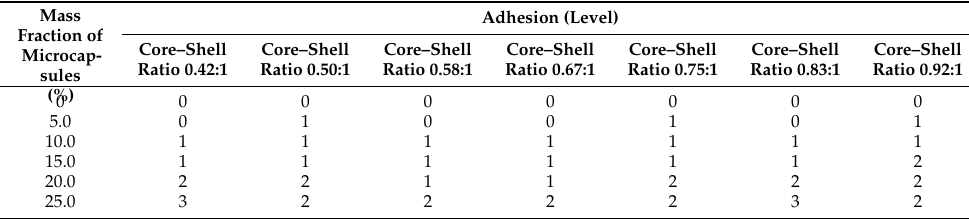
Table 4. The adhesion of the